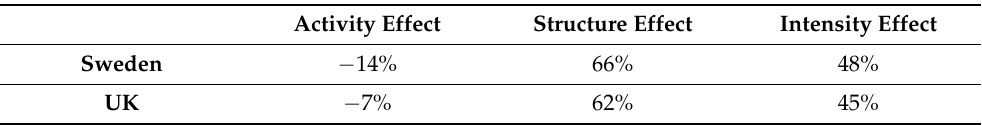
Table 3. Percentage contributions of activity, structure and intensity effects to overall change in final energy between 2020 and 2050 for household mobility in Sweden and the UK derived from ‘1.5C Total’ scenario. Negative figures indicate an increase in